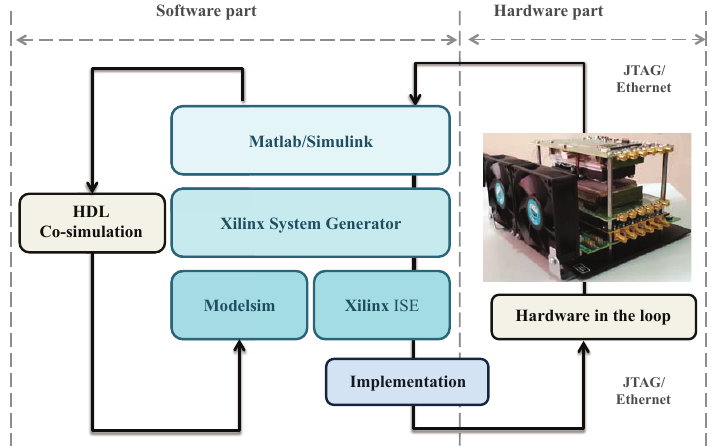
Figure 11. Hardware